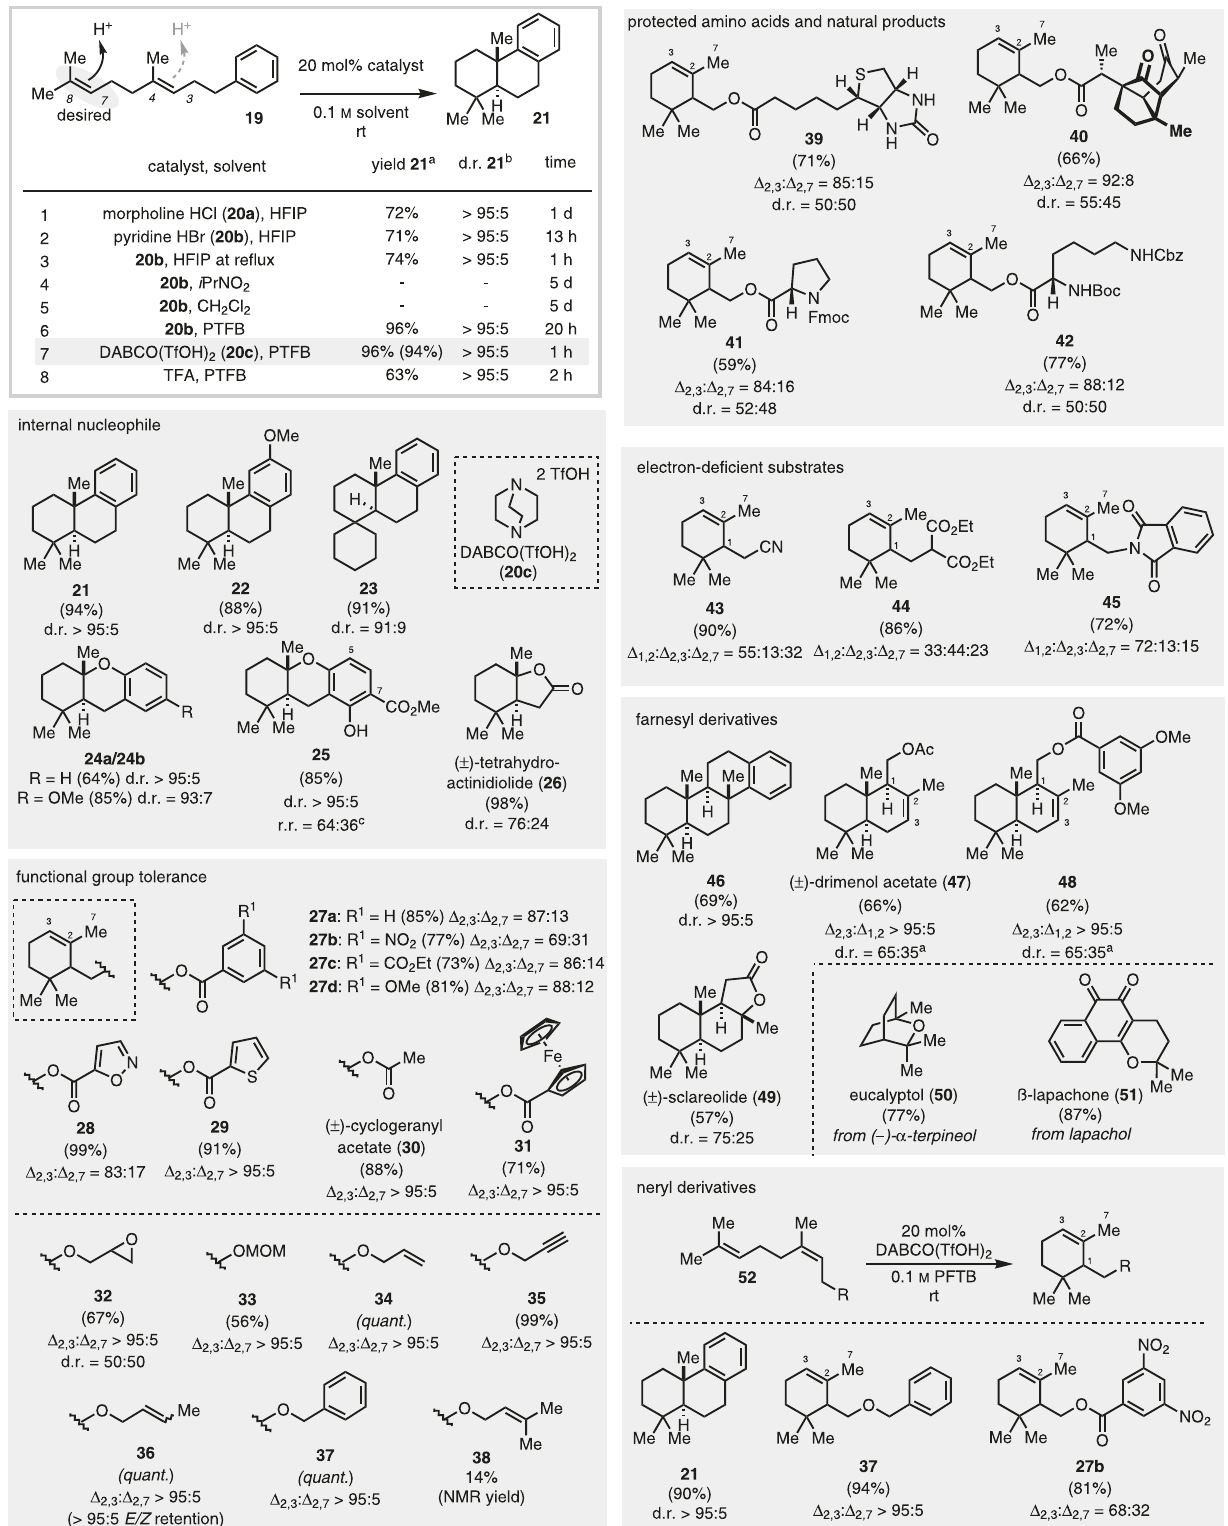
Fig. 2 | Optimization and scope of the proton-induced cyclization. Optimized reaction conditions: Substrate (1.0 eq) and DABCO(TfOH) 2 ( 20c , 20mol%) were dissolvedin0.1 M PFTBatrtunderairandstirreduntilcompletion.Allyieldsreferto isolated yields. a Determined by GC-FID from the crude reaction mixture using an